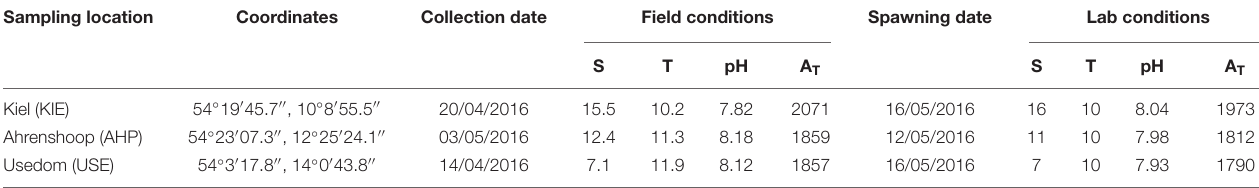
TABLE 1 | Parental mussel sampling sites and abiotic